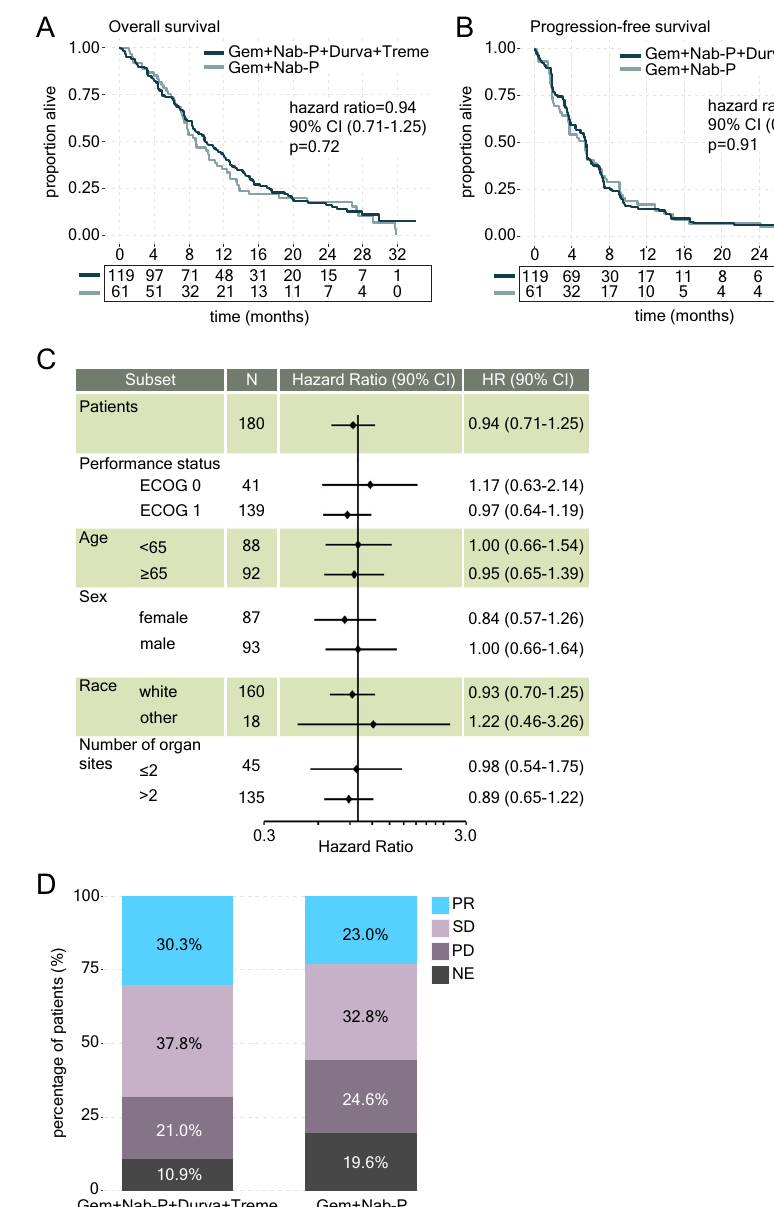
Fig. 1 | Combination dual checkpoint inhibition and chemotherapy was not associated with OS, PFS nor ORR in an unselected population of patients with metastatic PDAC. A Kaplan-Meier curve comparing overall survival (OS) between treatment arms. B Kaplan-Meier curve comparing progression-free survival (PFS) betweentreatment arms. C Forest plot showing results ofsubgroup analysisbased